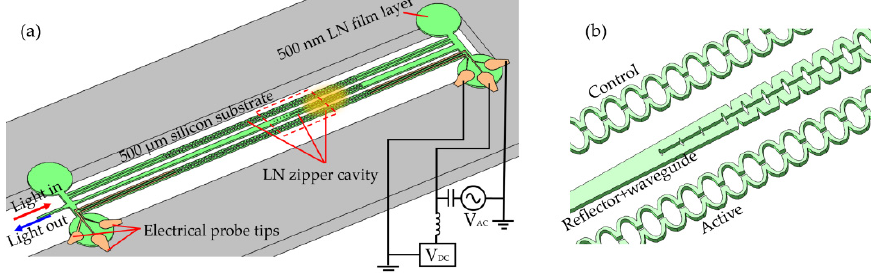
Figure 3. ( a ) Schematic of tunable longitudinally split PCN cavity; ( b ) longitudinal motion of side nanobeam [65]; ( c ) lateral motion of side nanobeam [66]; ( d ) bending of both sides of nanobeam [67]; ( e ) schematic of a tunable transversely split PCN cavity [68]. All red arrows indicate the motion direction.